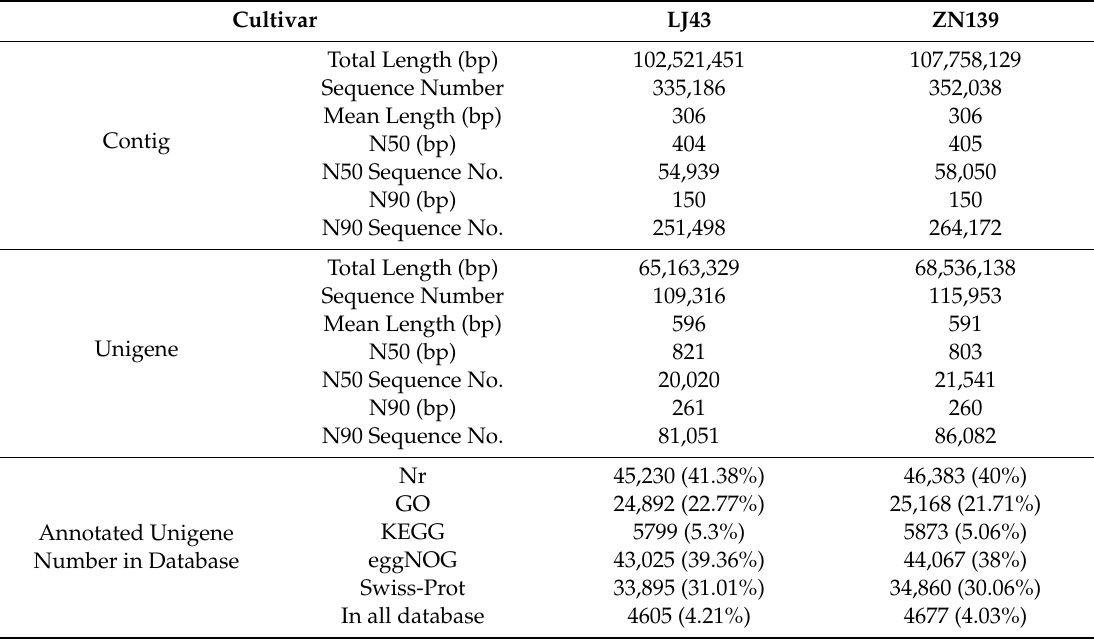
Table 2. Information of assembled contigs, unigenes and annotations for two